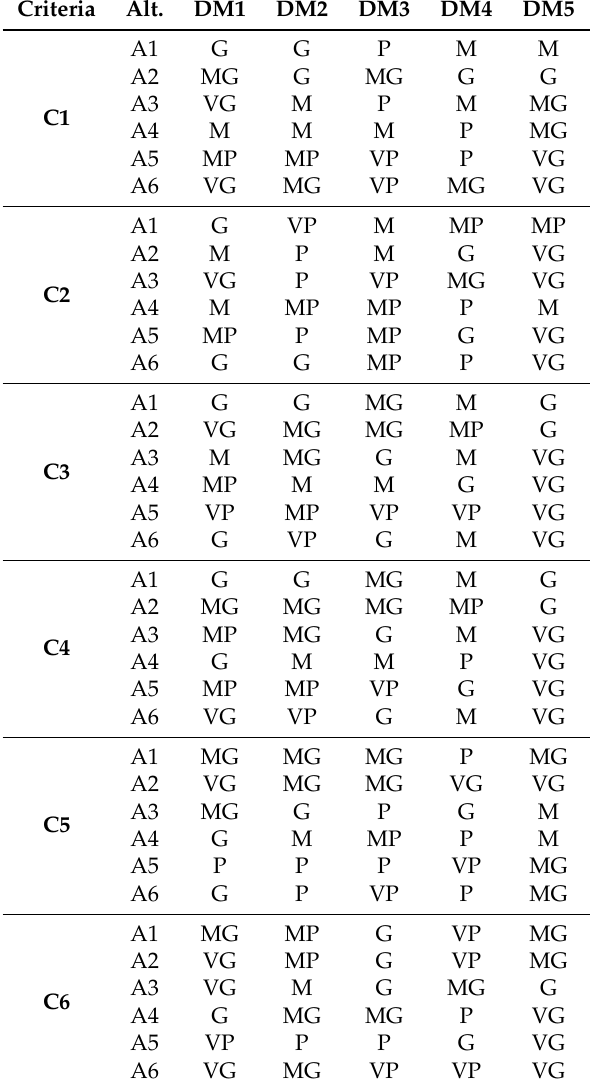
Table 6. DMs’ evaluations of alternatives by using linguistic variables. Criteria Alt.